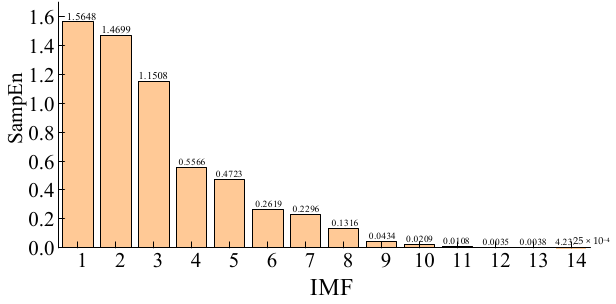
Figure 4. Sample entropy of each component.